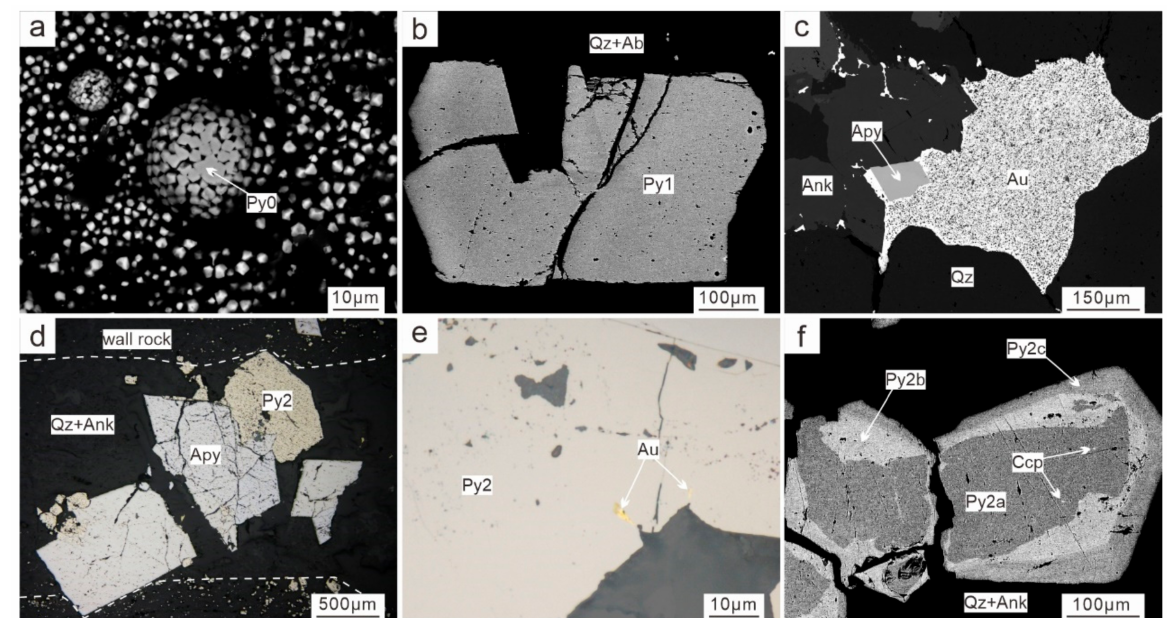
Figure 5. Photomicrographs showing the features of pyrite at different stages in the Dunbasitao gold deposit, among which the images in Figure 5d,e are microscopy photos, whereas the others are BSE images. ( a ) Pre-ore framboidal Py0 produced in Jiangbasitao Formation. ( b ) Py1 in the early stage is produced in a quartz–albite vein, which is internally homogeneous and poor in mineral inclusions. ( c ) This local micrograph of a middle-stage quartz–ankerite vein shows that the native gold filled in crystal fissures of quartz and ankerite, and the arsenopyrite intergrew with the gold. ( d ) Py2 intergrew with arsenopyrite in the quartz–ankerite vein in the middle stage. ( e ) Native gold inclusions produced in Py2 in the middle stage. ( f ) This BSE image shows the internal texture of Py2 produced in the quartz–ankerite vein in the middle stage; Py2 is composed of a dark and inclusion-rich core (Py2a), a bright mantle (Py2b), and a medium-bright rim (Py2c). The irregular border of Py2a and its relict texture indicates that Py2a has been replaced by Py2b, and the straight boundary between Py2b and Py2c indicates that Py2c overgrew on Py2b. Qz—quartz;